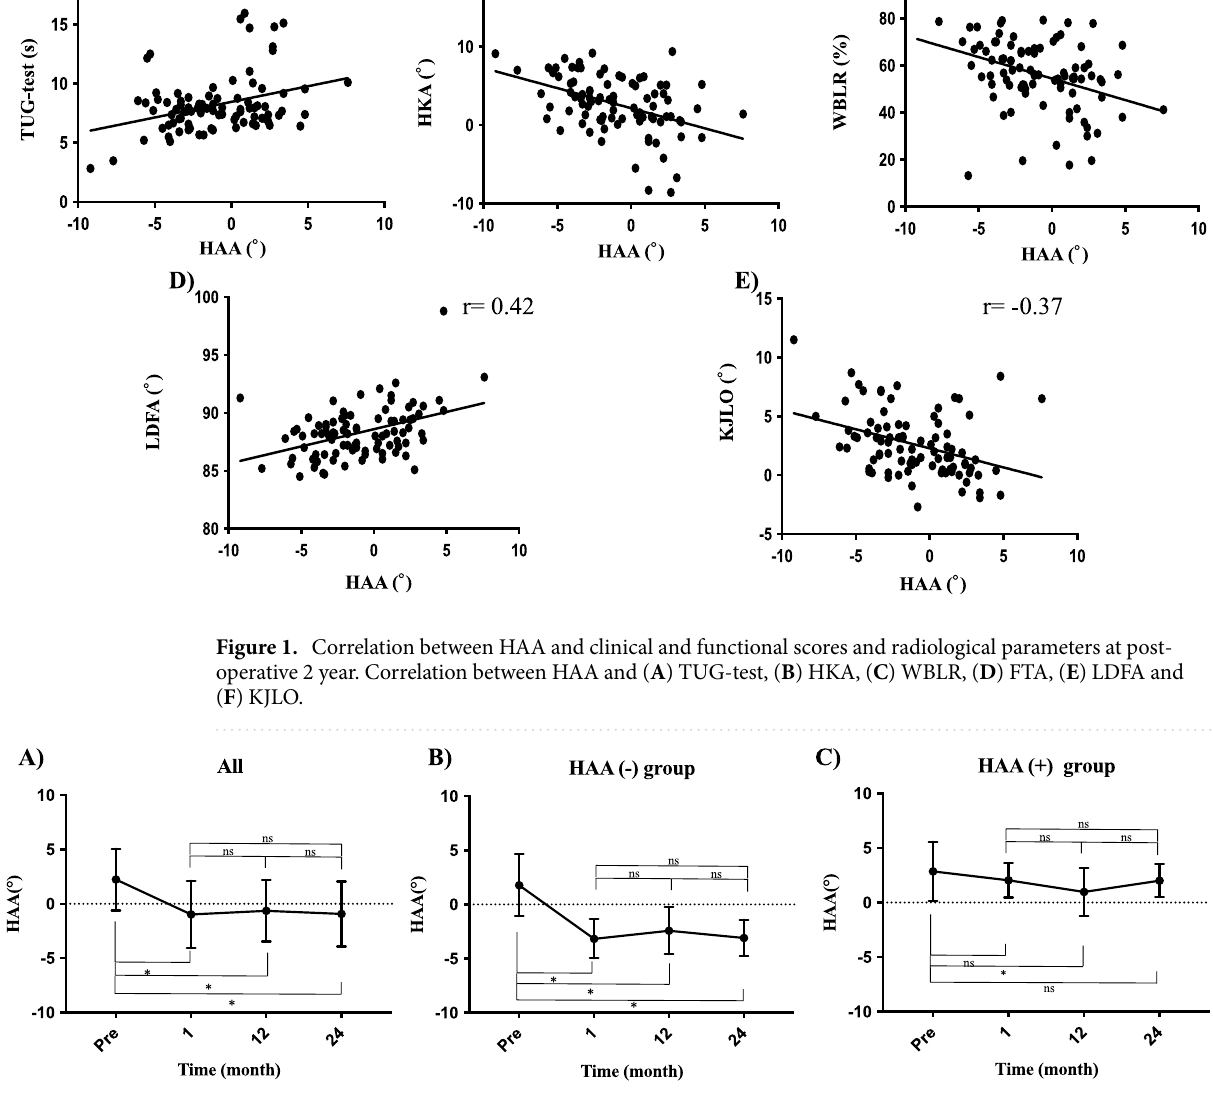
Figure 2. The transition of HAA during follow-up. The transition of HAA in ( A ) all patients, ( B ) HAA (+) group and ( C ) HAA(−)